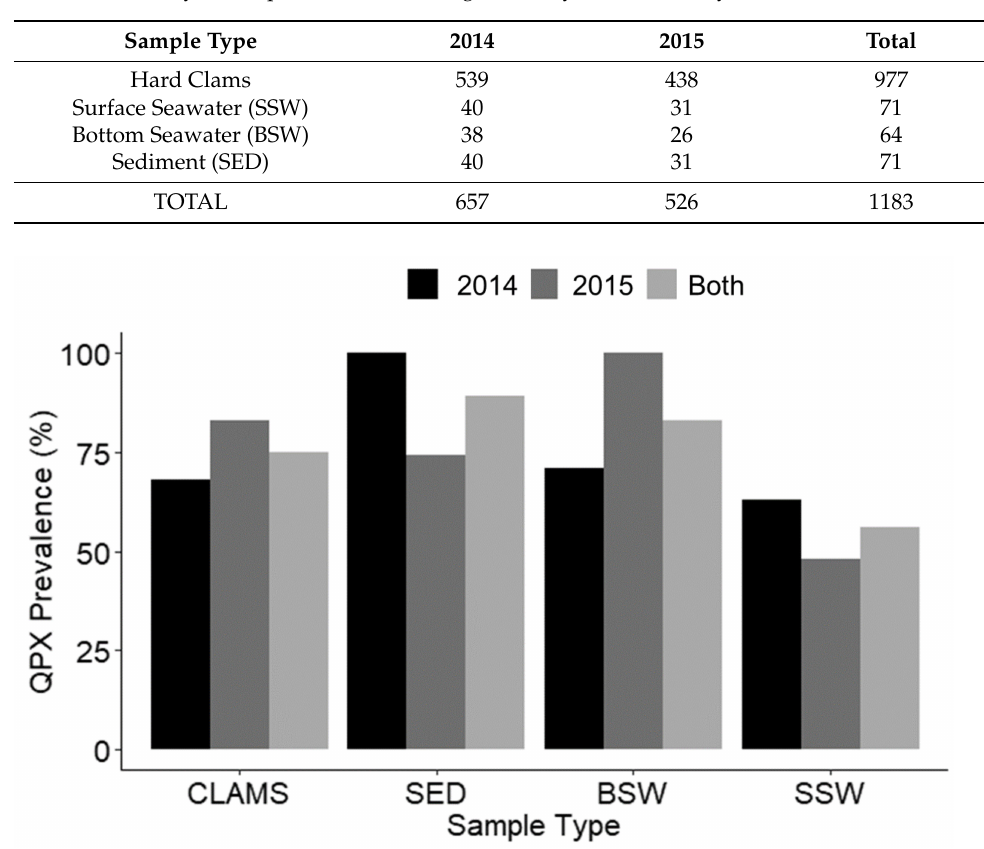
Figure 2. Summary of M. quahogii prevalence (%QPX-positive samples) by sample type and year. CLAMS: tissue samples, SED: sediment, BSW: bottom seawater, SSW: surface